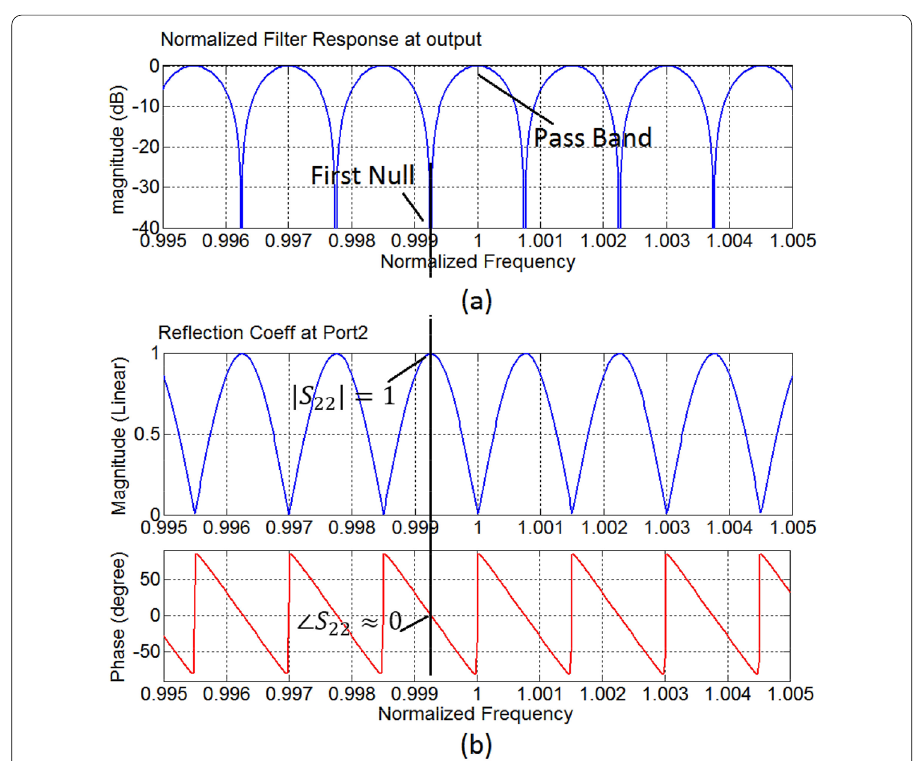
Fig. 8 Simulated filter response of the two-channel power combiner versus frequency. a The normalized filter transfer function. b The magnitude and phase of the reflection coefficient at one input